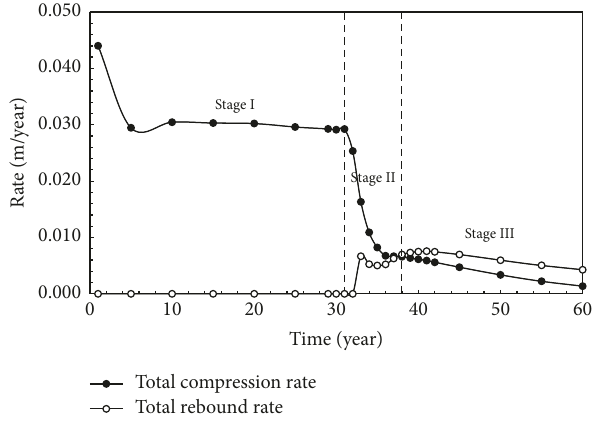
Figure 9: The total rate of compression and rebound during different